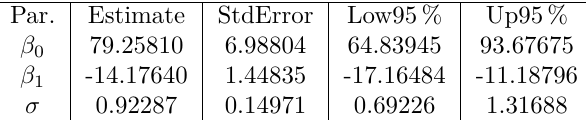
Table 4. Mean estimations for Material#1.